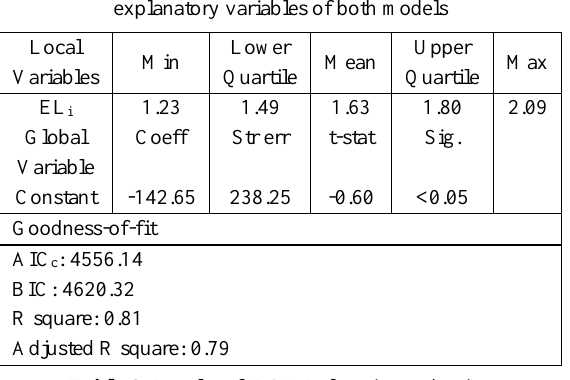
Table 6. Results of MGWR for trip production